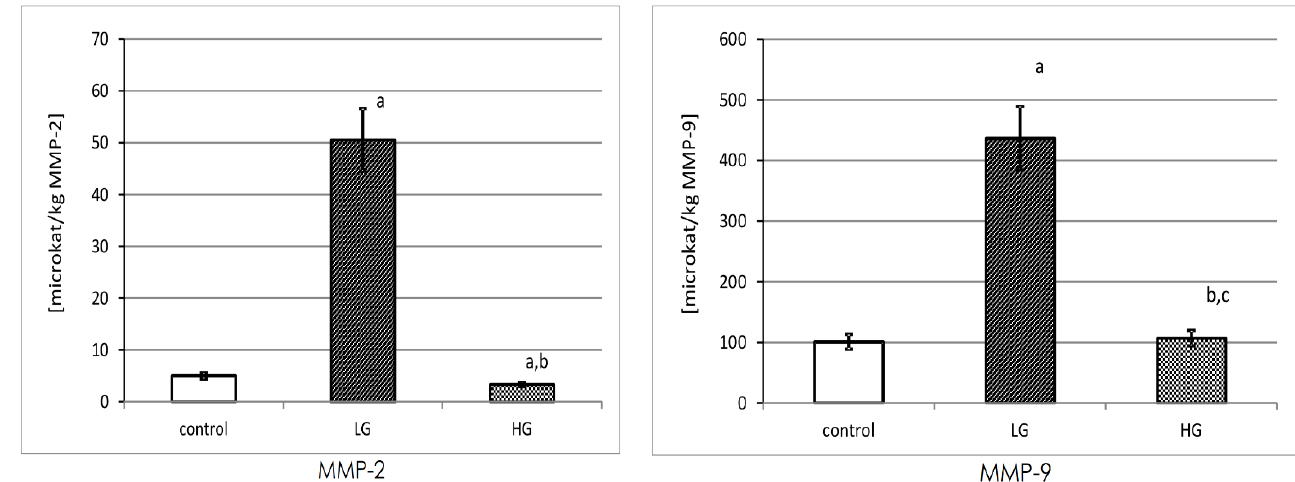
Figure 6. MMP-2 and MMP-9 specific activity in control tissue ( n = 10) and low-grade (LG) ( n = 10) and high-grade (HG) ( n = 10) urinary bladder cancer. MMP-2: a — p < 0.001 cancer vs. urinary bladder control. b — p < 0.001 high-grade vs. low-grade urinary bladder cancer. MMP-9: a — p < 0.001 low grade-cancer vs. urinary bladder control. b — p < 0.05 high-grade cancer vs. urinary bladder control. c — p < 0.001 high-grade vs. low-grade urinary bladder cancer.